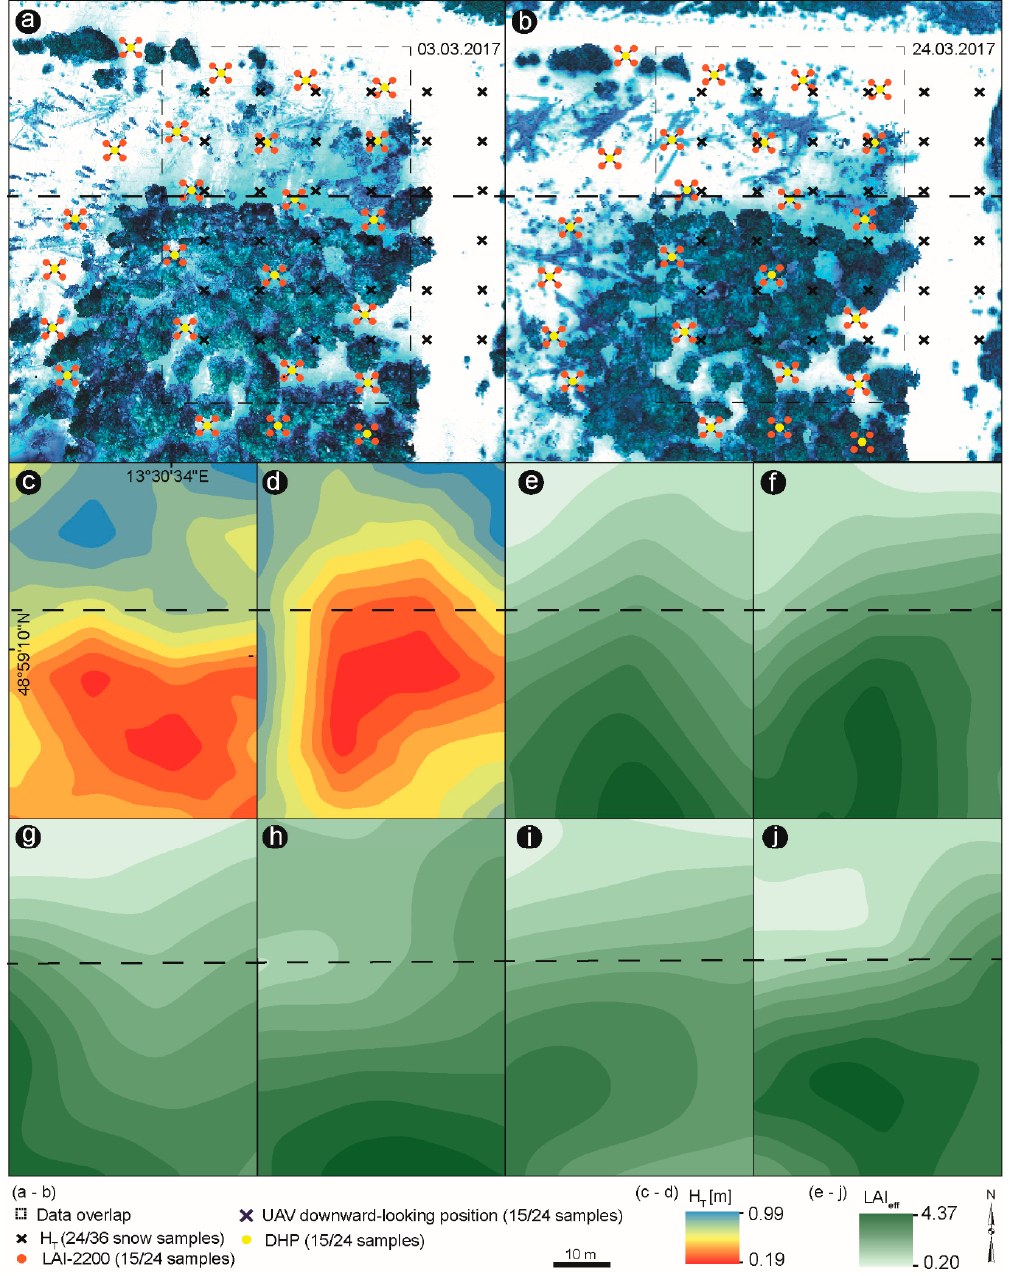
Figure 10. Field plot sampling design. ( a , b ) Snow depth measurements (H T ) taken at 10 m interval during snow accumulation and snow ablation period with visualized ground-based measurements of LAI and UAV downward-looking positions at 24 points. Interpolated H T probes during snow accumulation ( c ) and ablation ( d ). Interpolated ground measurements of LAI-2200 ( e ); digital hemispherical photography (DHP) ( f ); UAV-based LAI eff at 50 m ( g ) and 65 m ( h ) during snow accumulation; UAV-based LAI eff at 50 m ( i ) and 65 m ( j ) during snow ablation. All data were interpolated within the data overlap frame, which displays the overlapping area of snow depth sampling (H T ) and ground-based measurements of LAI. Different colors indicate different values of snow thickness and LAI values. Black dashed line separates the healthy forest from the bark beetle-infected forest